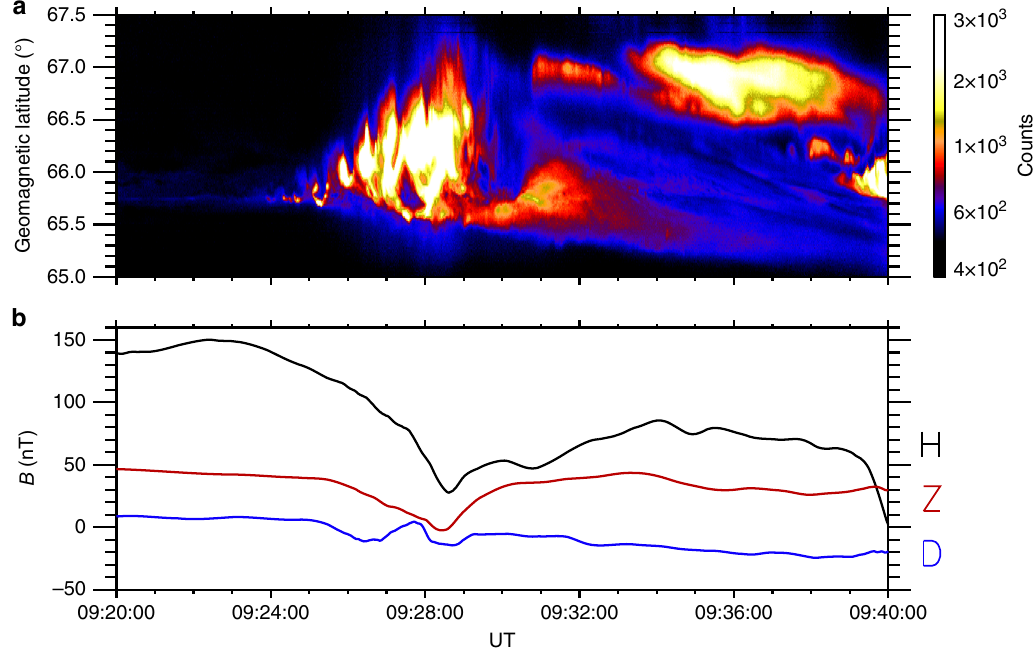
Fig. 5 An overview of the auroral and magnetic measurements during the substorm event. a Vertical slice through centre of the ASI to generate North- South keogram of event. Faint pre-existing arc is visible from 09:20:00 UT at 65.75 MLAT. The arc visibly brightens at 09:24:00 and shortly after the aurora expand poleward to 67.2 MLAT. b The de fl ections in the magnetic fi eld components at the POKR magnetometer show the formation of the magnetic bay around the same time as the auroral signature of the substorm